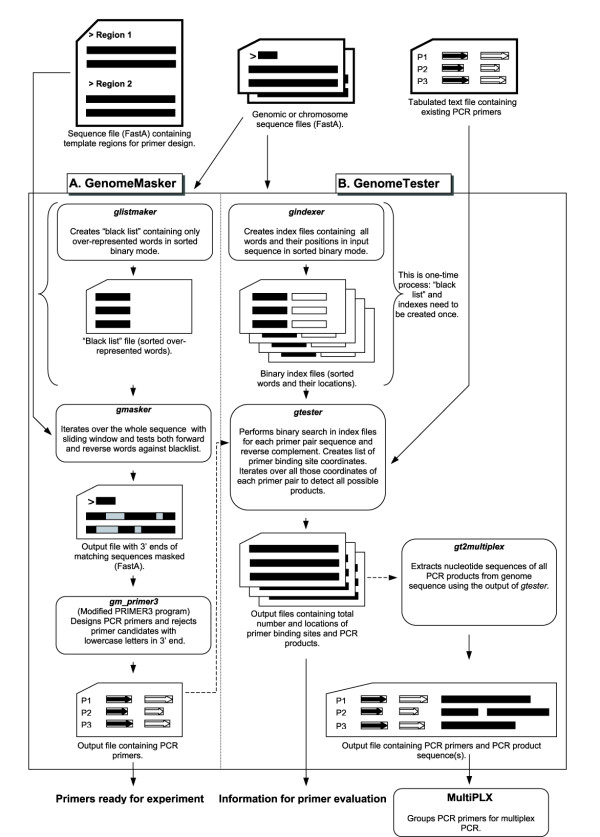
The workflow of the two separate units in GENOMEMASKER package: GenomeMasker (A) and GenomeTester (B). Boxes with rectangular corners describe data structures, rounded boxes describe procedures performed by different programs and boxes with bold outlines denote the main input files. Procedures indicated by dashed lines are optional.